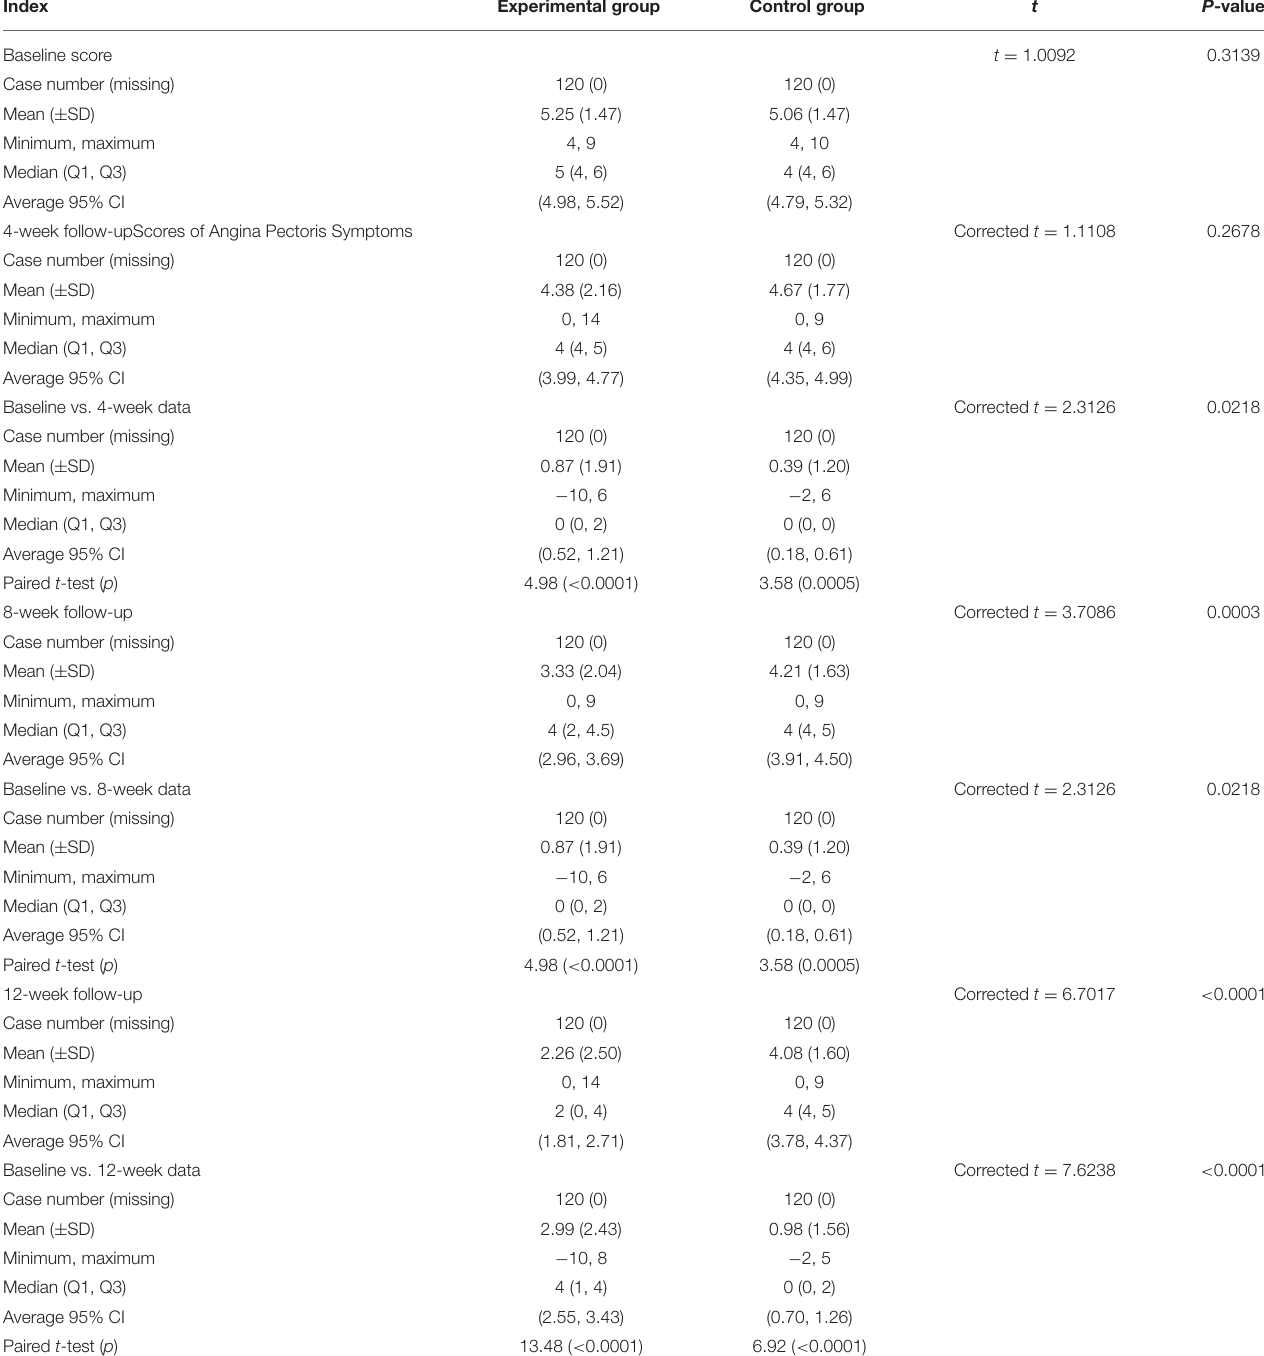
TABLE 5 | Comparison of total scores of angina pectoris symptoms during the follow-up period